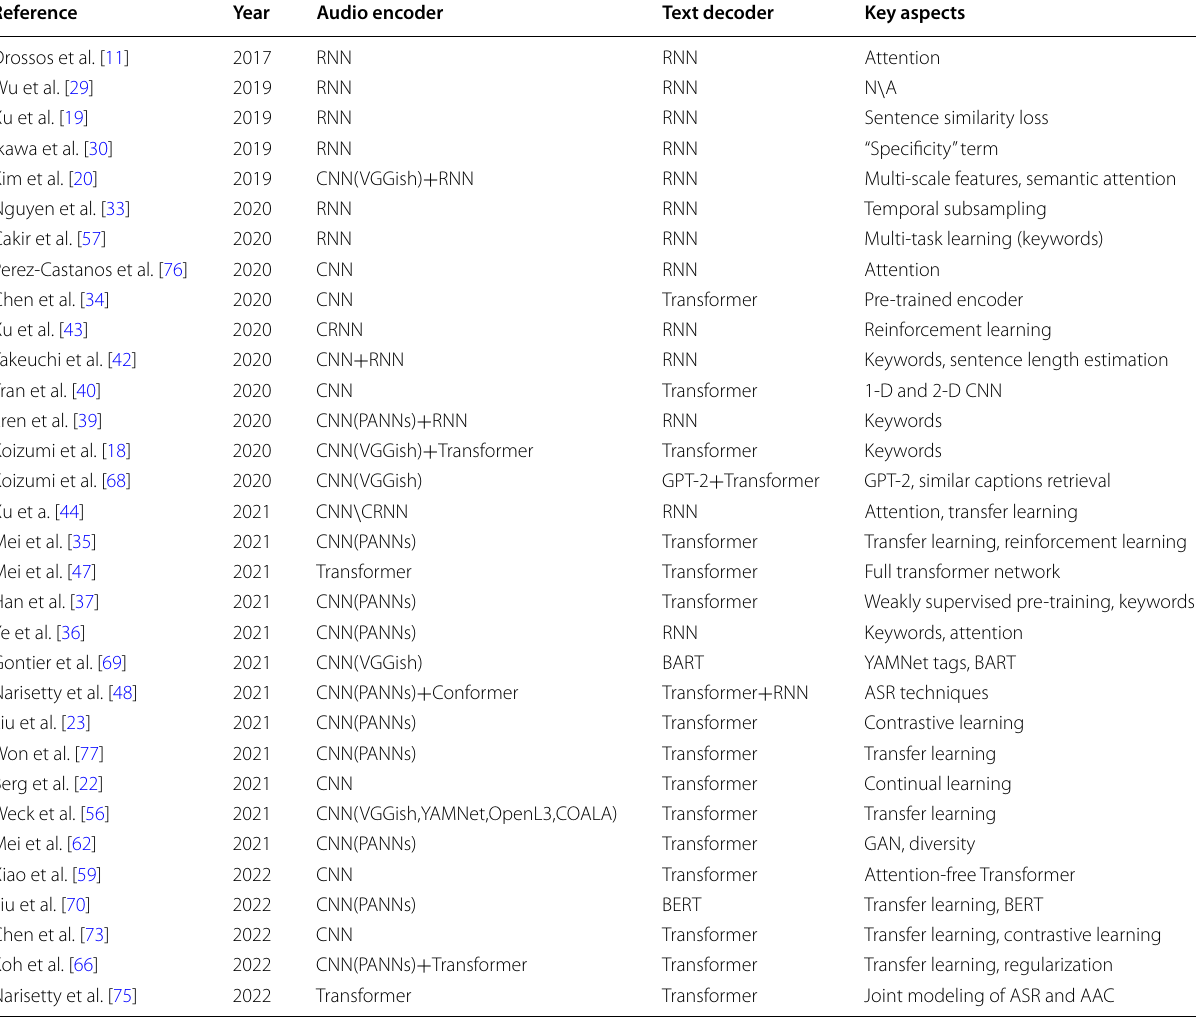
Table 1 An overview of published methods for audio